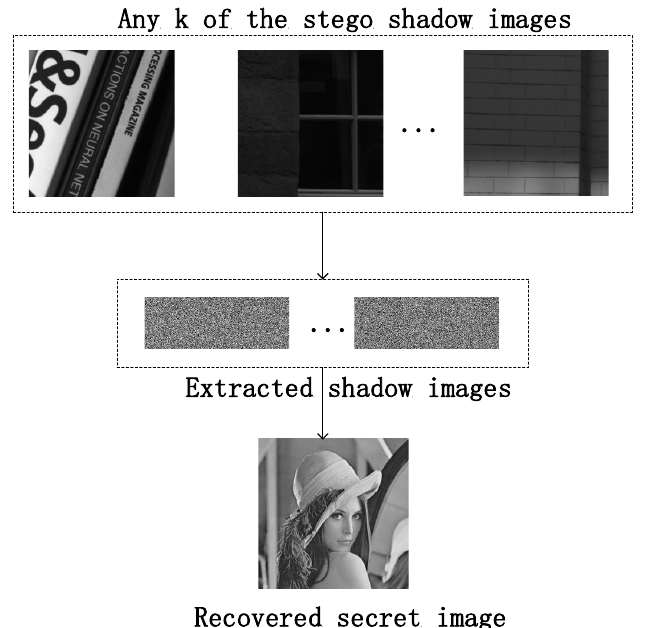
Figure 3. The recovery model of the proposed scheme